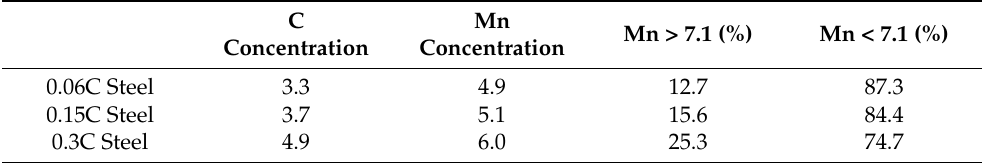
Table 3. Relative mean concentration and the percentage of each concentration range of C and Mn.